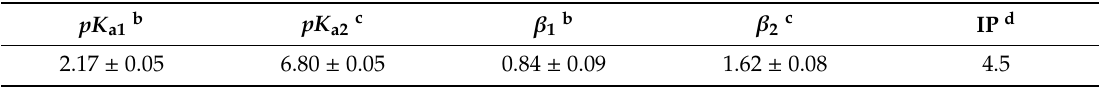
Table 2. pK a and β values of M- l -Gln in the α range 0.2–0.8 ( β 1 ) and 0.1–0.9 ( β 2 ). a